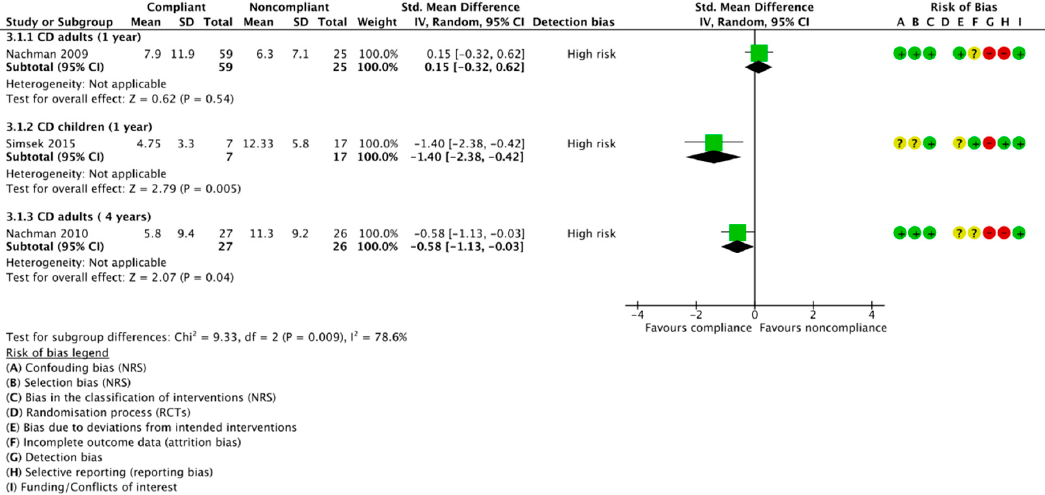
Figure 6. Mean depression scores in compliant vs. noncompliant CD adults at one year, CD children at one year, and CD adults at four years after following a GFD.